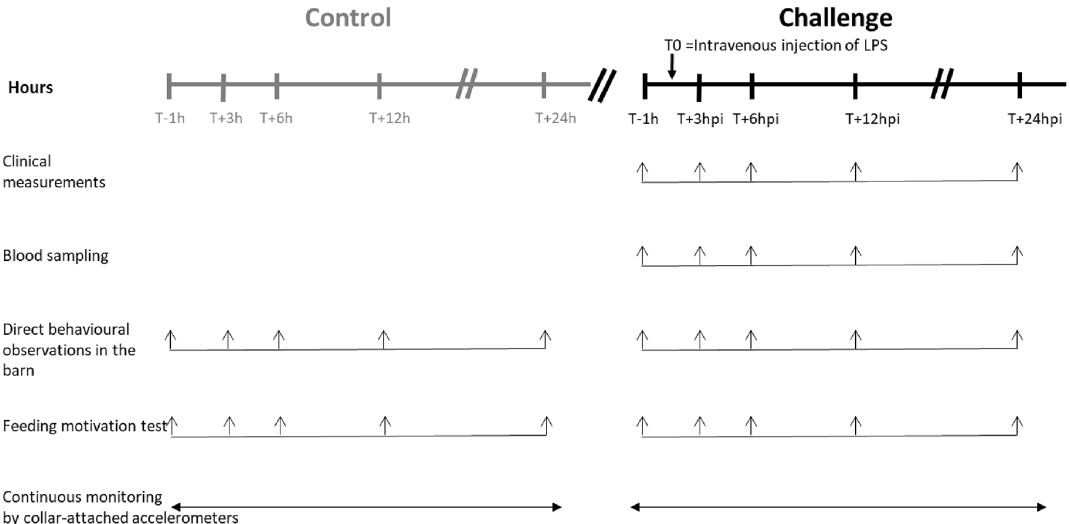
Figure 1. Schedule of measures to investigate the effects of intravenous injection (at T0) of lipopolysaccharide (LPS) (0.5 µg/kg of BW) on clinical and blood parameters and behavioural indicators in 14 Holstein cows. Each cow was first submitted to the control situation then challenged with LPS, or vice